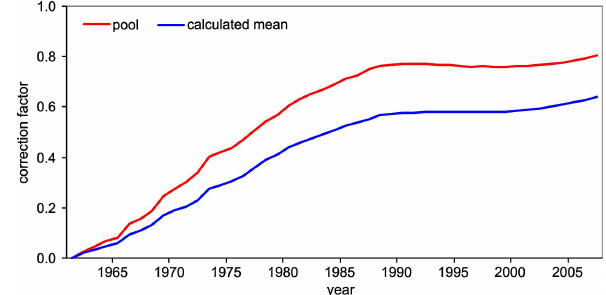
Fig. 5. Annual pin correction values added to atmospheric cor- rected carbon isotope series calculated for a pooled pin corrected chronology and a mean chronology calculated from five individ- ually pin corrected series from site Capannelle (1961–2227AD). Both chronologies consists of the same five